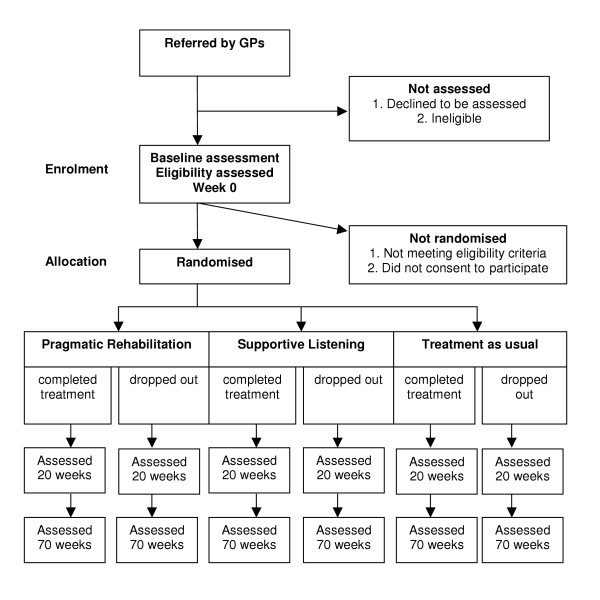
CONSORT diagram.